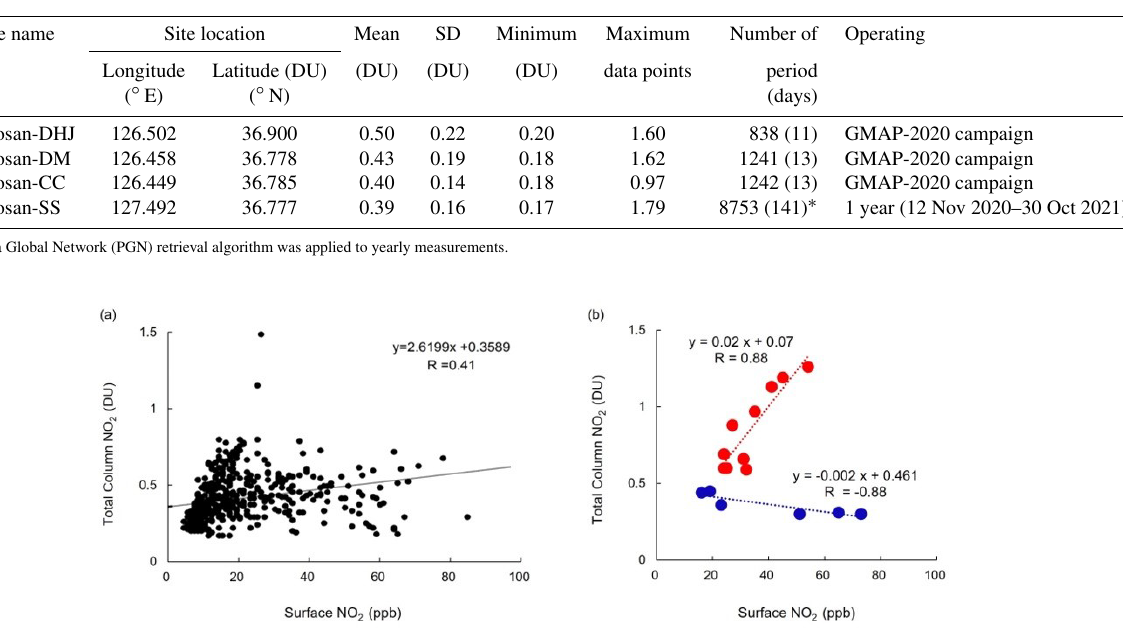
Figure 3. (a) Pandora column (PC) NO 2 measurements as a function of surface in situ (SI) NO 2 observations at Pandora sites PA 1 –PA 3 during the GMAP-2020 campaign and PA 4 during a 1-year period. A 1 : 1 linear regression model was used to evaluate the relationship between PC and SI measurements (black line). (b) Sample scatterplots of PC-NO 2 and SI-NO 2 for 24 February (red) and 21 April 2021